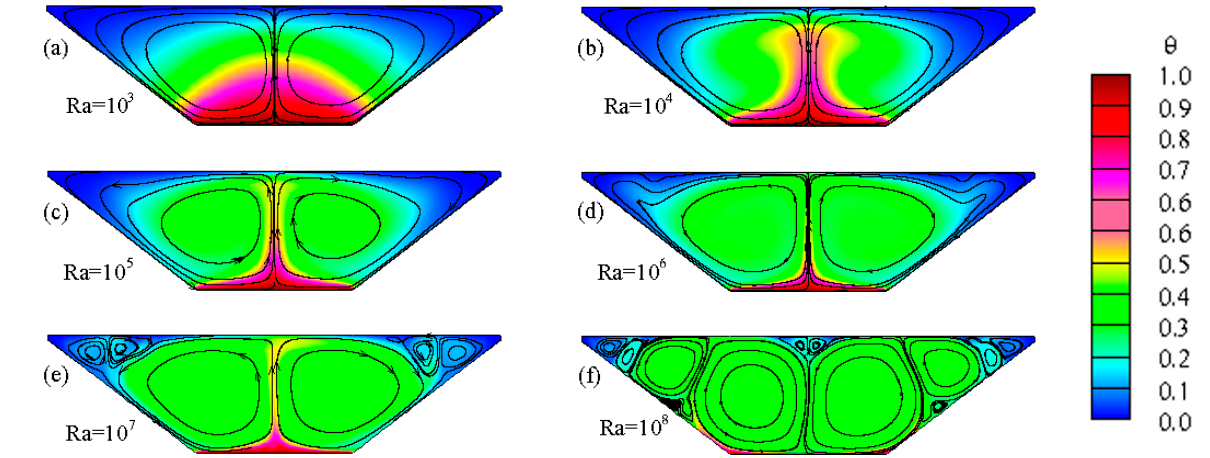
Figure 8. Streamlines and isotherms at the fully developed stage for the different Rayleigh numbers ( a ) Ra = 10 3 , ( b ) Ra = 10 4 , ( c ) Ra = 10 5 , ( d ) Ra = 10 6 , ( e ) Ra = 10 7 , ( f ) Ra = 10 8 , at τ = 2000.